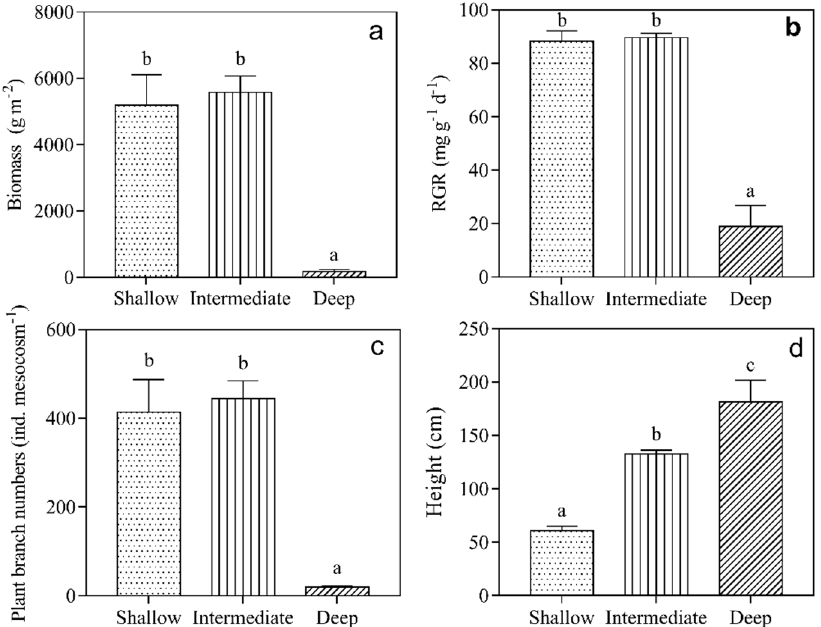
Figure 2. Comparisons of ( a ) biomass (g m − 2 ), ( b ) RGR (mg g − 1 d − 1 ), ( c ) plant branch numbers (ind. mesocosm − 1 ), and ( d ) plant height (cm) of H. verticillata among three water depth groups. Values represent mean ± SD (n = 4). Means with different letters are significantly different ( p < 0.05) . Water depth also prominently affected the total biomass and the biomass ratio of V.